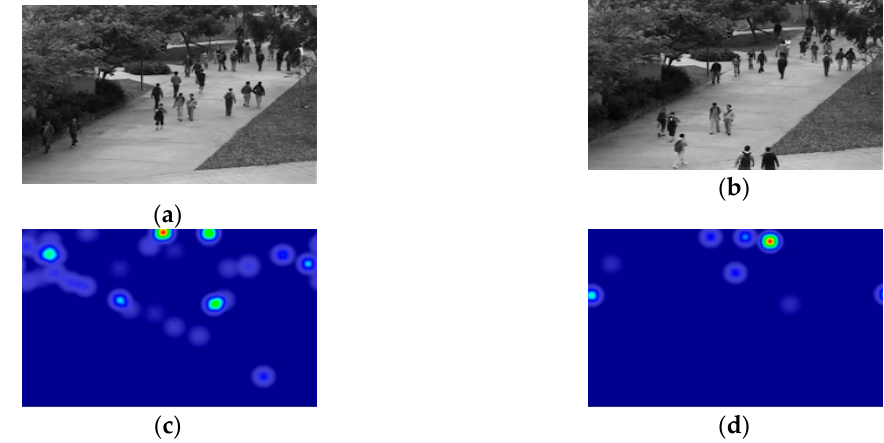
Figure 10. Two sample images in UCSD dataset. ( a , b ) are two sample images in UCF_CC_50 dataset. ( c , d ) are their density map generated by DSA-CNN for two images, respectively.